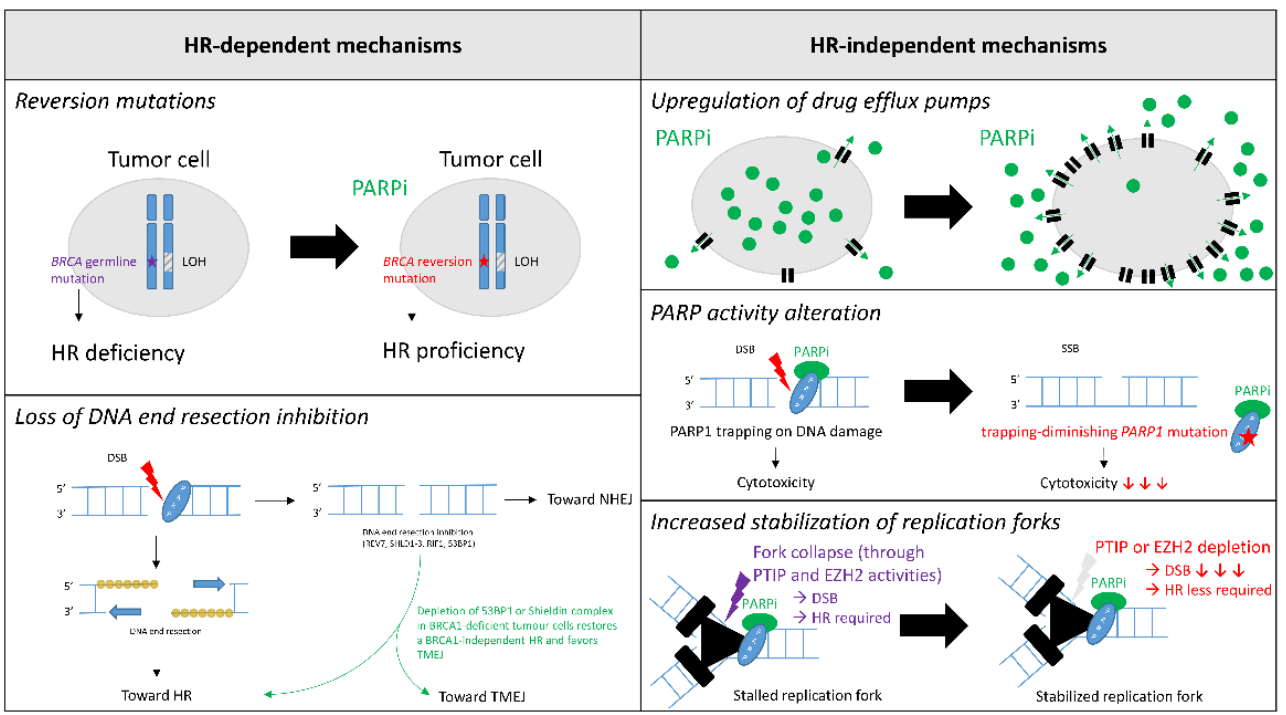
Figure 1. Synthetic representation of PARP inhibitors resistance mechanisms. Abbreviation: DSB = Double strand break; HR = Homologous recombination; LOH = Loss of heterozygosity; NHEJ = Non-homologous end-joining; PARP = Poly(ADP-ribose) polymerase; PARPi = PARP inhibitors; SSB = Single strand break; TMEJ = Theta-mediated end-joining.